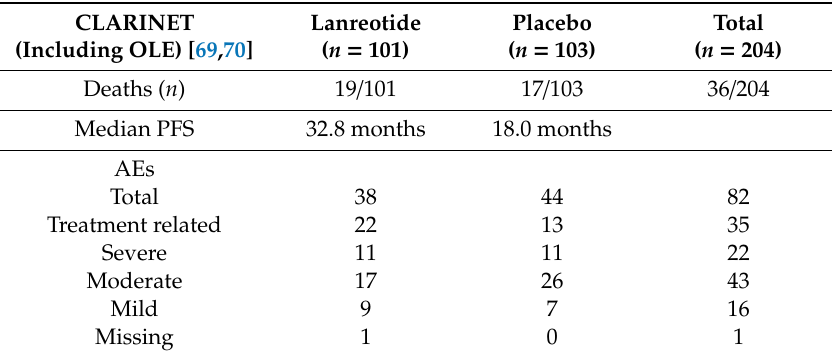
Table 2. Long-term results from the CLARINET trial (including